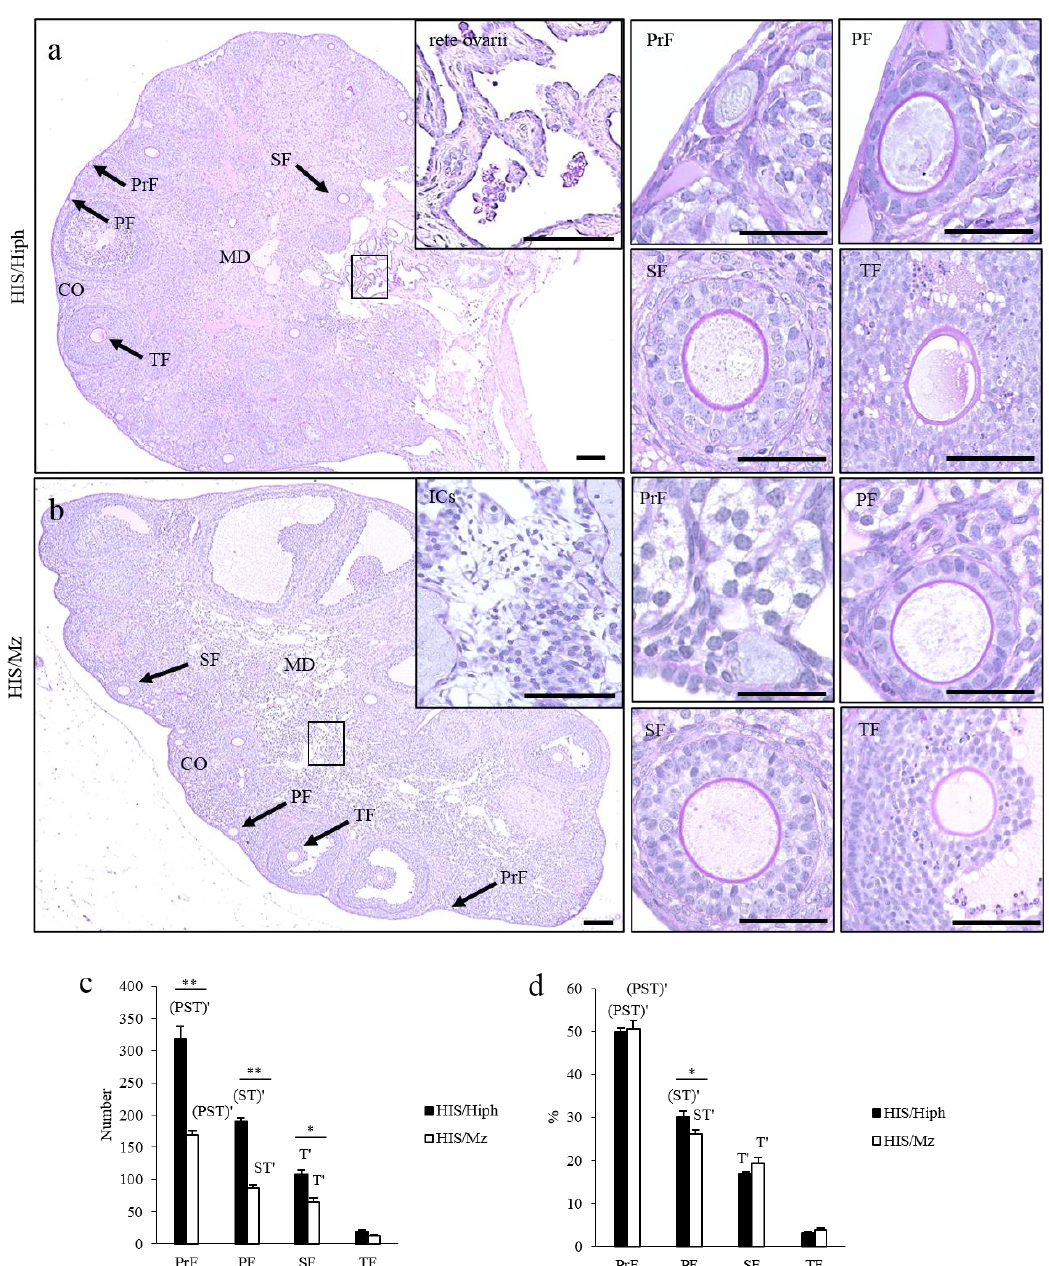
Figure 2. Histology of the ovaries of HIS/Hiph and HIS/Mz. ( a , b ) Histological observation of periodic acid Schiff–hematoxylin-stained ovary section from 4- week- old HIS/Hiph and HIS/Mz. The classified follicles shown in panels a and b (arrows) are further magnified to highlight primordial (PrF), primary (PF), secondary (SF), and tertiary (TF) follicles in both strains. Panels ( a ) and ( b ) show the regions of the ovary divided as cortex (CO) and medulla (MD). Panel a also shows the remnants of the rete ovarii (inset). Panel b shows the interstitial cells (ICs) (inset). The square area indicates the same area of insets. Scale bars = 200 µ m or 50 µ m (magnified and inset). ( c , d ) The total number and percentage of each follicle type classified as PrF, PF, SF, and TF in the ovary of HIS/Hiph and HIS/Mz. The percentage was calculated from the number of each follicle type/total number of follicles. Values are the mean ± standard error. Asterisks indicate significant differences between HIS/Hiph and HIS/Mz within a follicle type (Mann–Whitney U -test, * p < 0.05 and ** p < 0.01), and letters (Pr, P, S, and T) denote significant differences in the number of PrF, PF, SF, and TF in same strain (Kruskal–Wallis test followed by Scheffe’s method, p < 0.05). Dashes beside letters indicates a highly significant difference ( p < 0.01). N = 5 in each